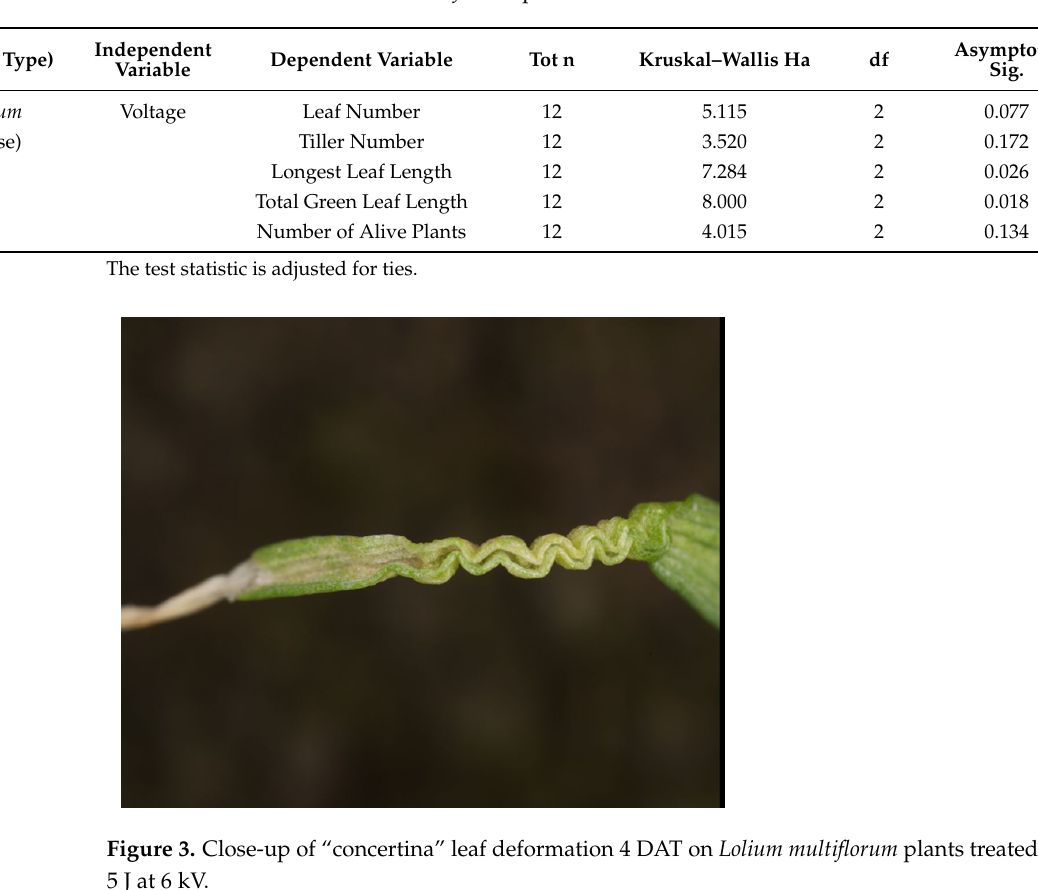
Table 4. Statistical Summary of Independent Samples Kruskal–Wallis Test for a range of biometric variables measured on Lolium multiflorum plants 15 DAT.